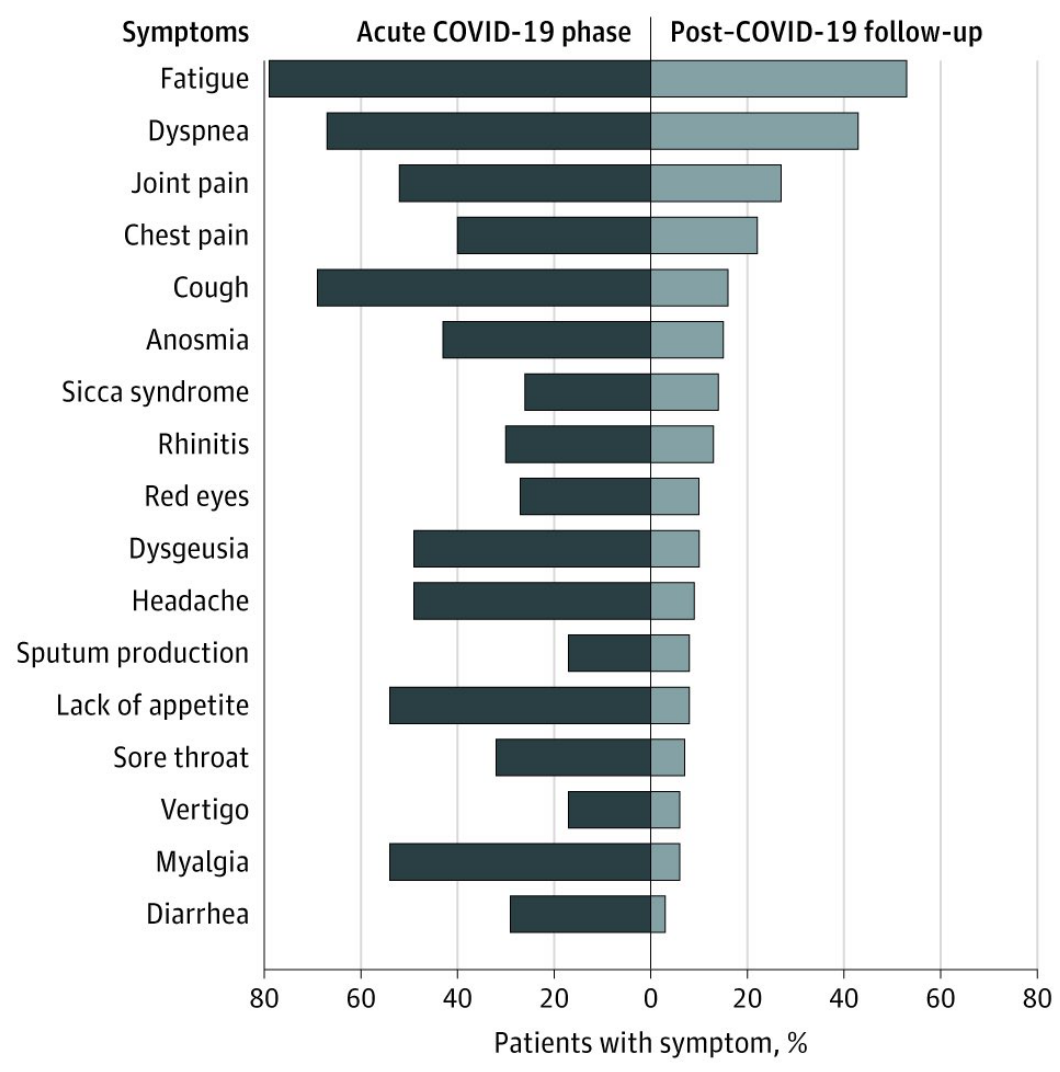
Figure 2. COVID-19